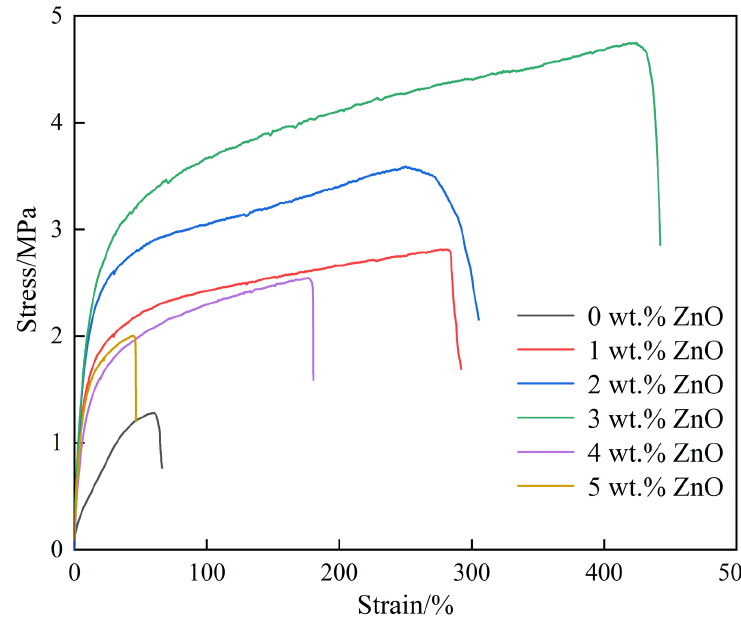
Figure 3. Stress–strain curves of the SPEs (0 wt.% ZnO [26], 1–5 wt.% ZnO). Table 2. Four parameters in the mechanical properties of the